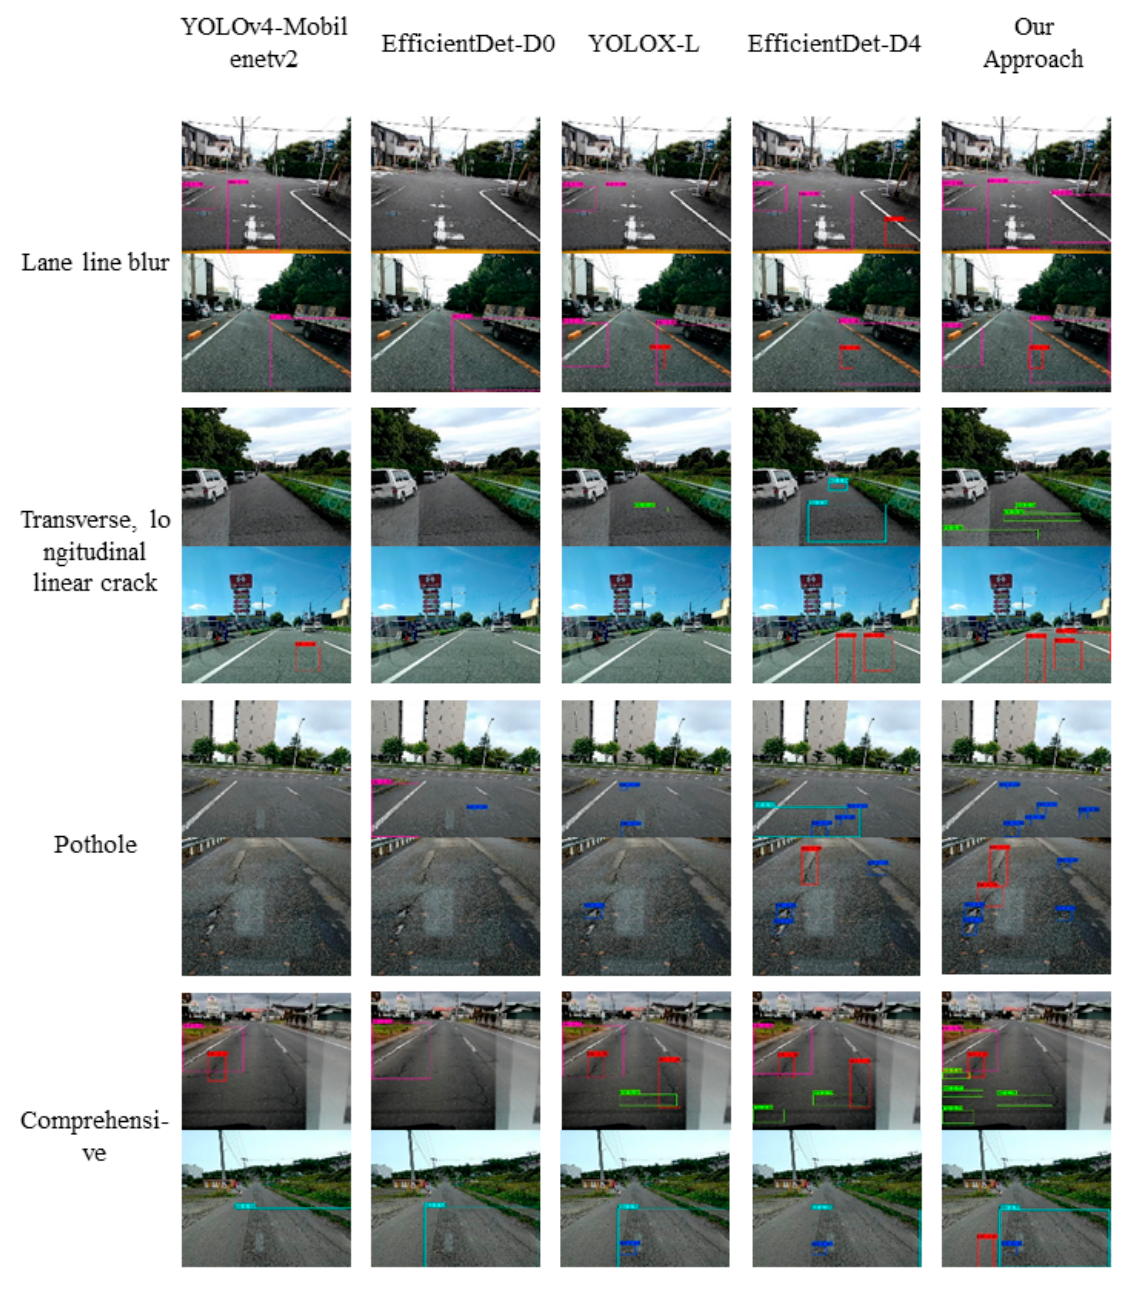
Figure 13. Comparison of detection samples of four representative models with the proposed method.